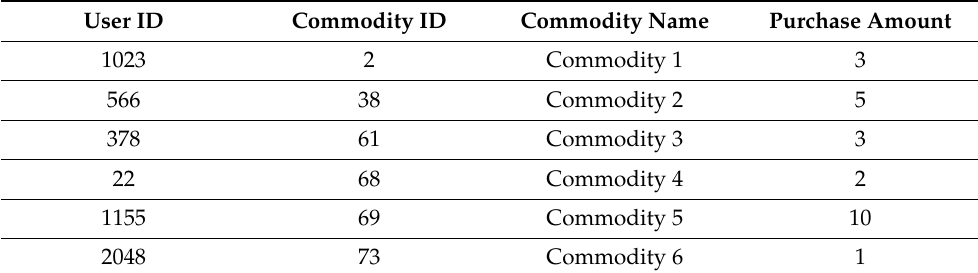
Table 3. Description of some commodities in T-APP.